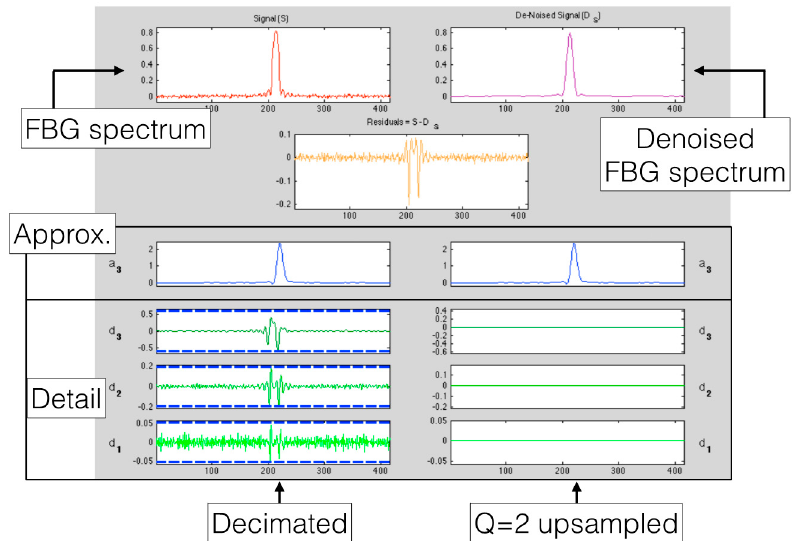
Figure 15. DWT denoising of an FBG spectrum. The original noisy spectrum (blue) is filtered through a DWT → thresholding → IDWT cycle once (red) and twice (green) for denoising. Daubechies wavelets db1 ( left ) and db3 ( right ) have been used.